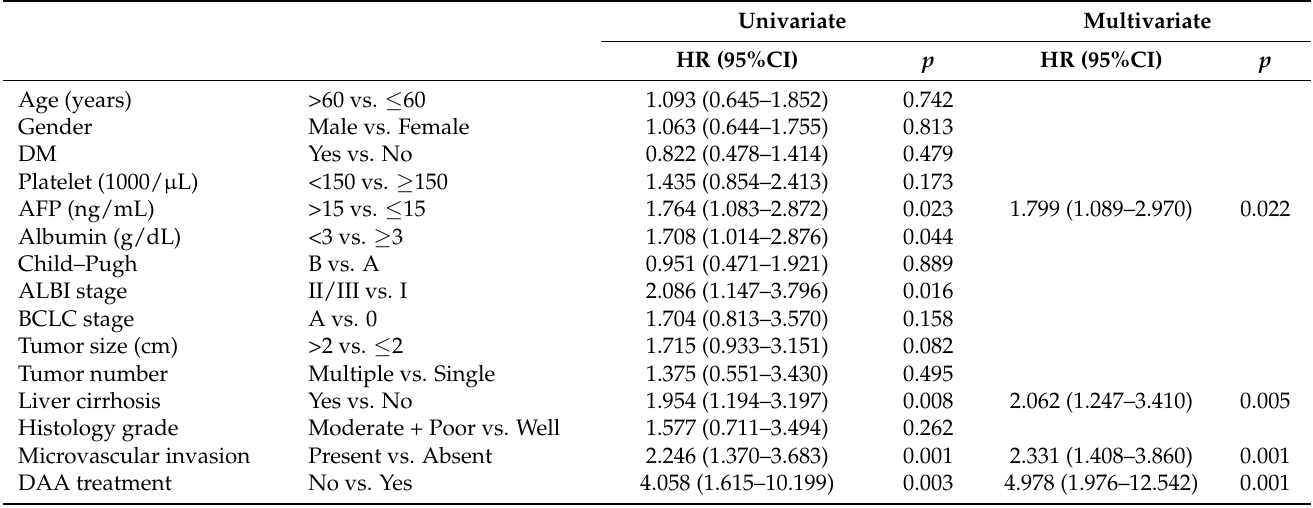
Table 2. Uni- and multivariate analyses of prognostic factors for recurrence in HCC. Univariate Multivariate